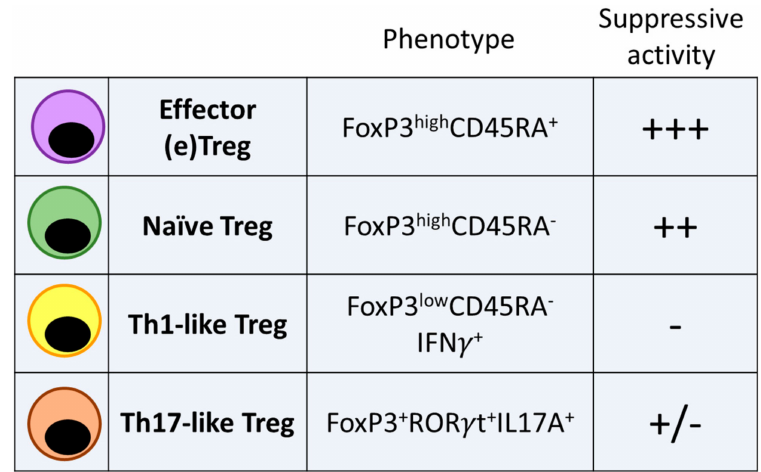
Figure 3. Phenotype and functional activity of Tregs subsets identified in sporadic CRC and